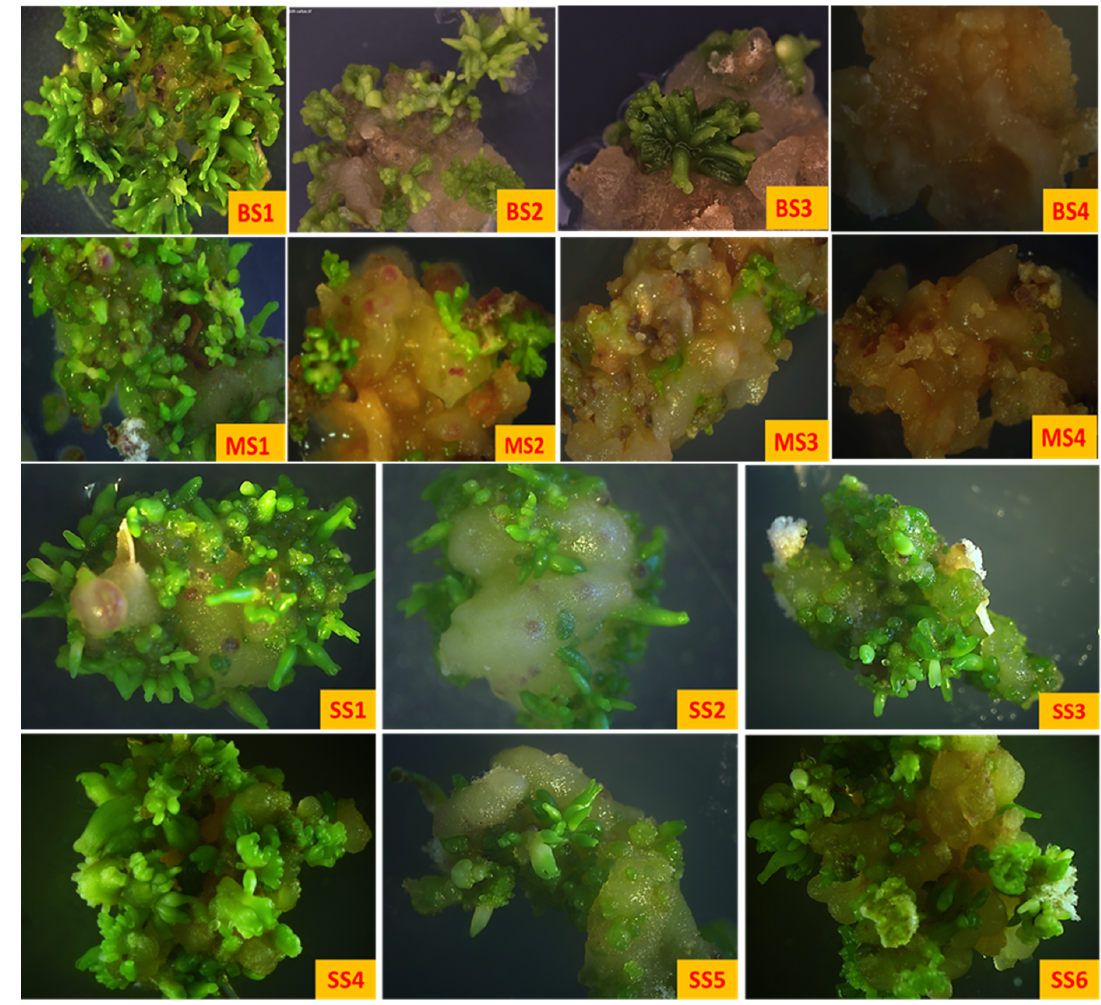
Figure 9. Embryogenic sustainability of the callus through the subculture cycles. (BS1–BS4) Embryogenic sustainability of the B5h callus from the first to fourth subculturing, (MS1–MS4) embryogenic sustainability of the MS2D callus from the first to fourth subculture and (SS1–SS6) embryogenic sustainability of the SH4K callus from first to sixth subculture. All images were taken after 21 days on the EDM medium. All images were at 8× magnification.